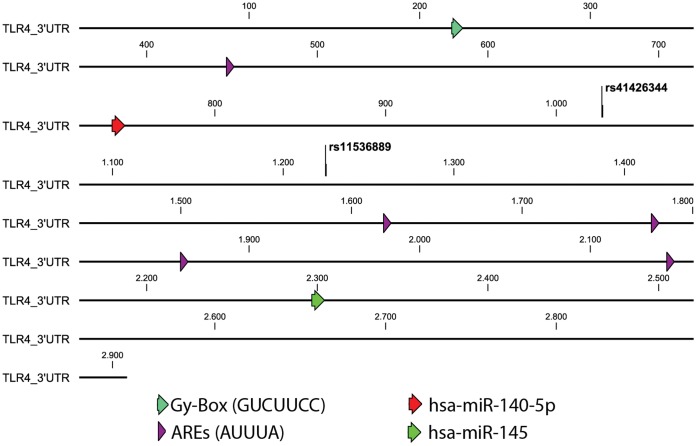
Scheme of TLR4 3′UTR, indicating the sequence variants studied and its regulatory regions.